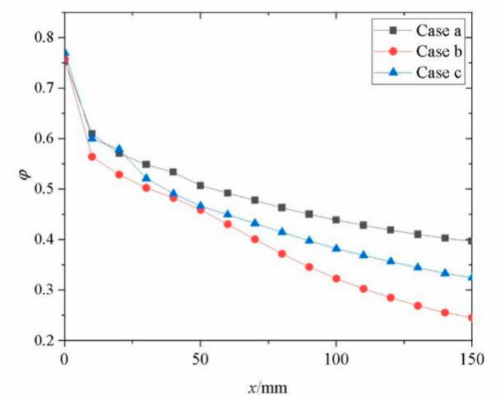
Figure 14. Non-uniformity coefficients for Case a, Case b, and Case c along the x -axis.